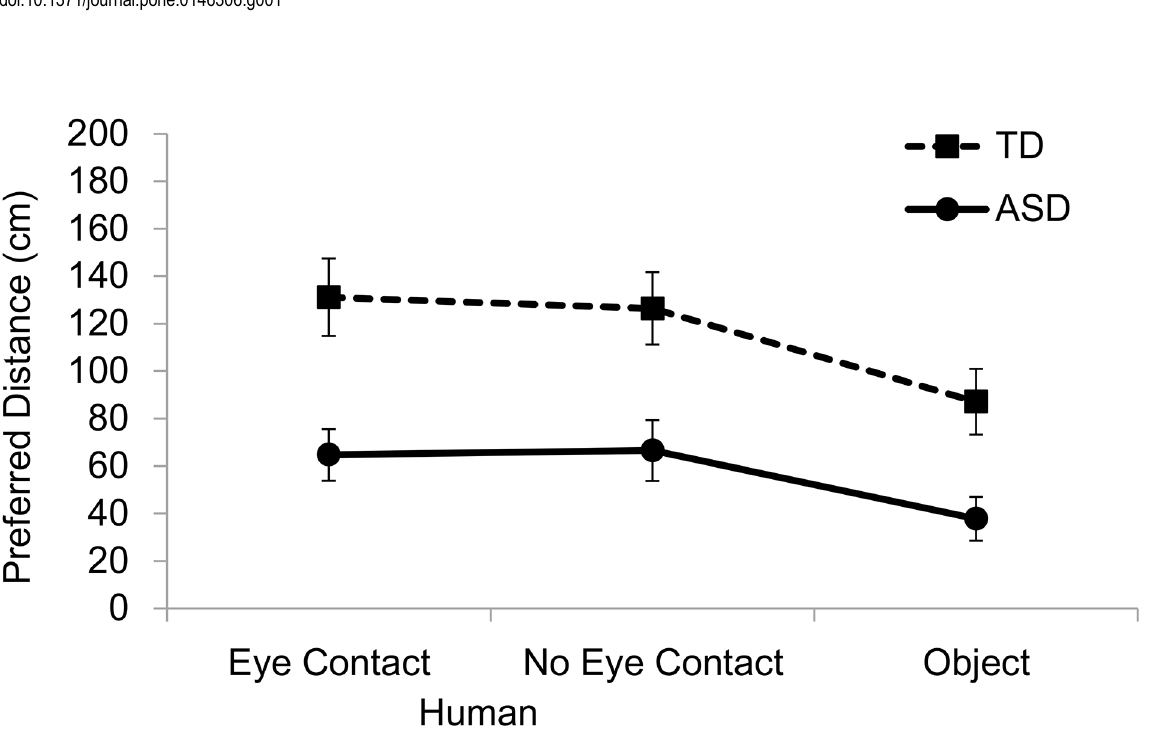
PLOS ONE | DOI:10.1371/journal.pone.0146306 January 27,